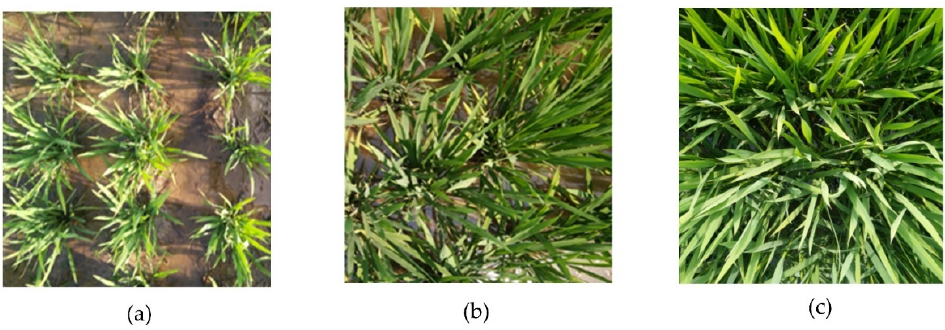
Figure 3. The appearance of rice at different growth stages: ( a ) tillering stage, ( b ) jointing stage, and ( c ) booting stage.